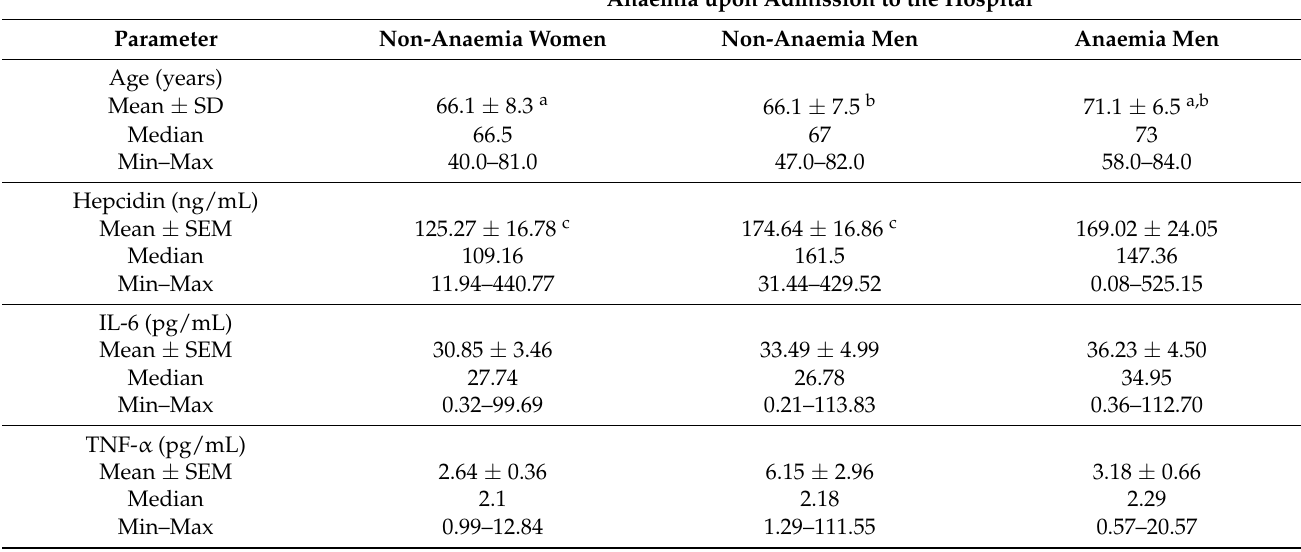
Table 5. Descriptive statistics of age and hepcidin, IL-6, TNF- α , CRP, and SAA 1 levels in lung cancer patients, subdivided by the presence of anaemia at the time of admission to the